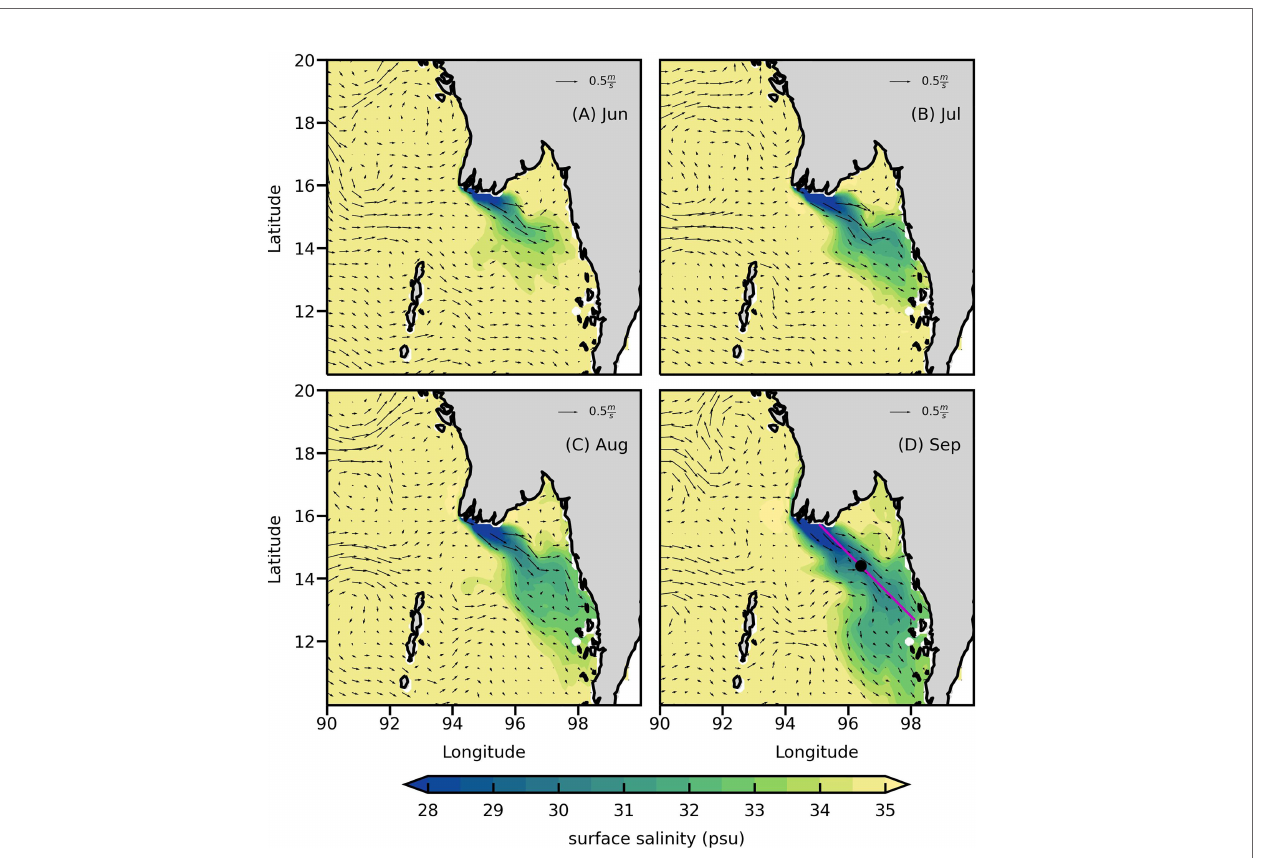
FIGURE 4 | Maps of monthly averaged sea surface salinity (psu) and surface currents (ms -1 ) from the fi rst year of experiment IRFullW. Solid magenta line in panel (D) represents an axis of the IR jet along which the time evolution of the jet has been analyzed. The black dot on this axis shows the location where the annual cycle of the momentum terms has been